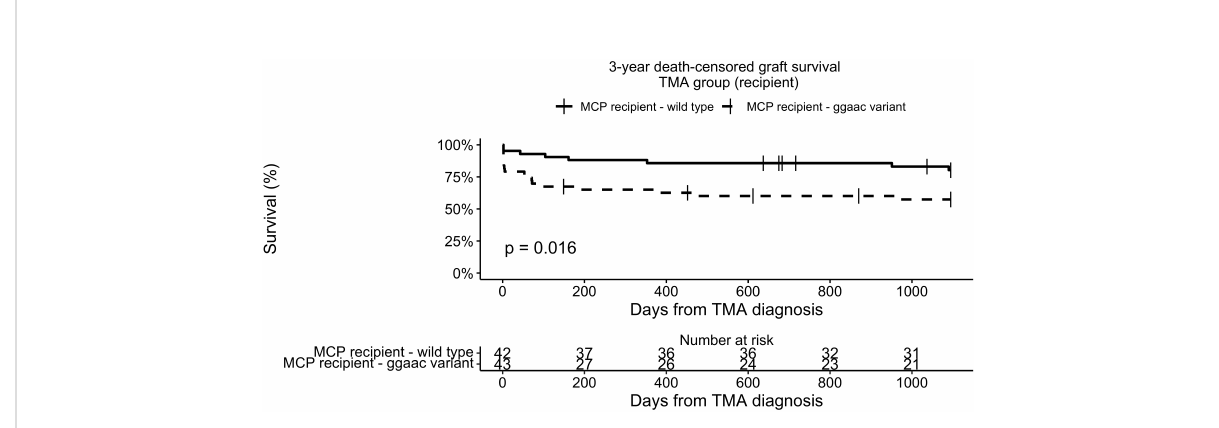
FIGURE 3 3-year death-censored graft survival in the TMA group according to recipient